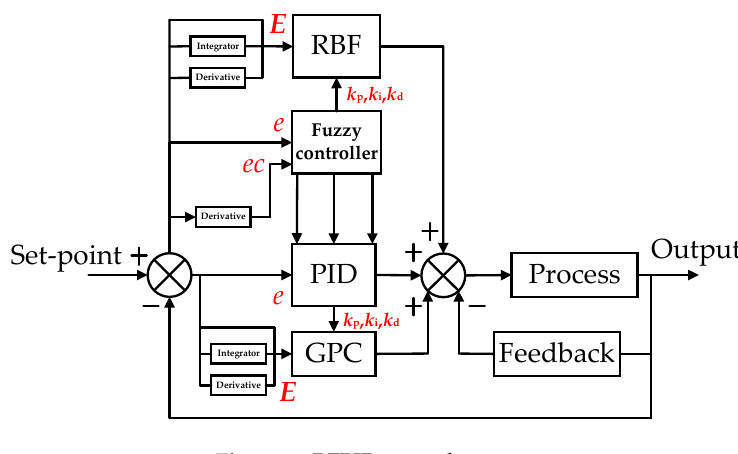
Figure 8. RFPID control system.